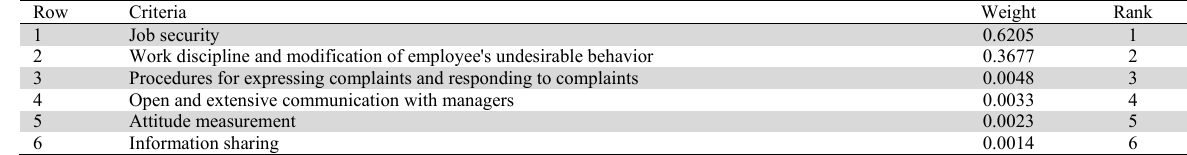
Ranking of employee communication